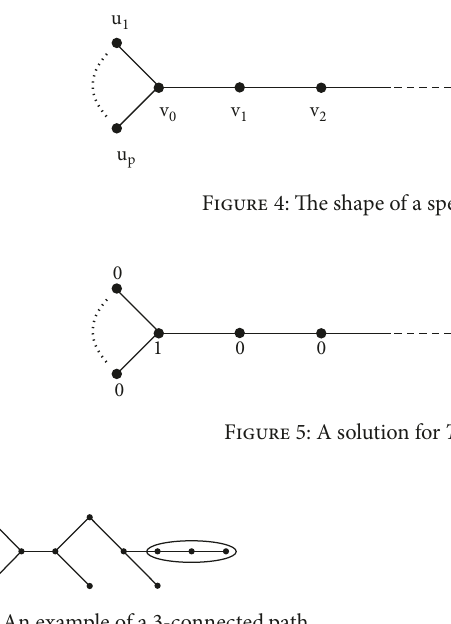
Figure 6: An example of a 3-connected